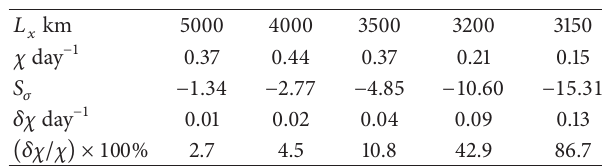
Table 1: Changes in the growth rates of unstable waves for the case